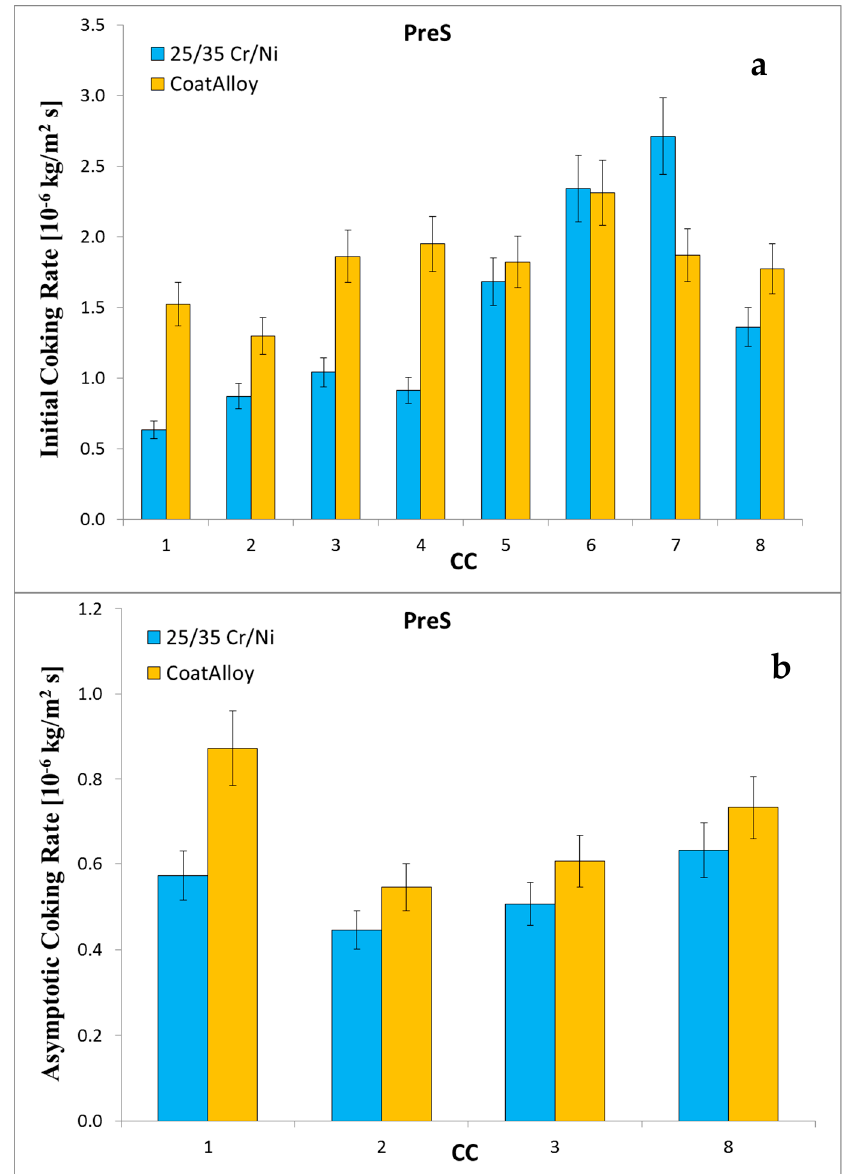
Figure 4. Initial ( a ) and asymptotic ( b ) coking rates for the Presulfiding runs for the reference (blue) and CoatAlloy (yellow) sample.